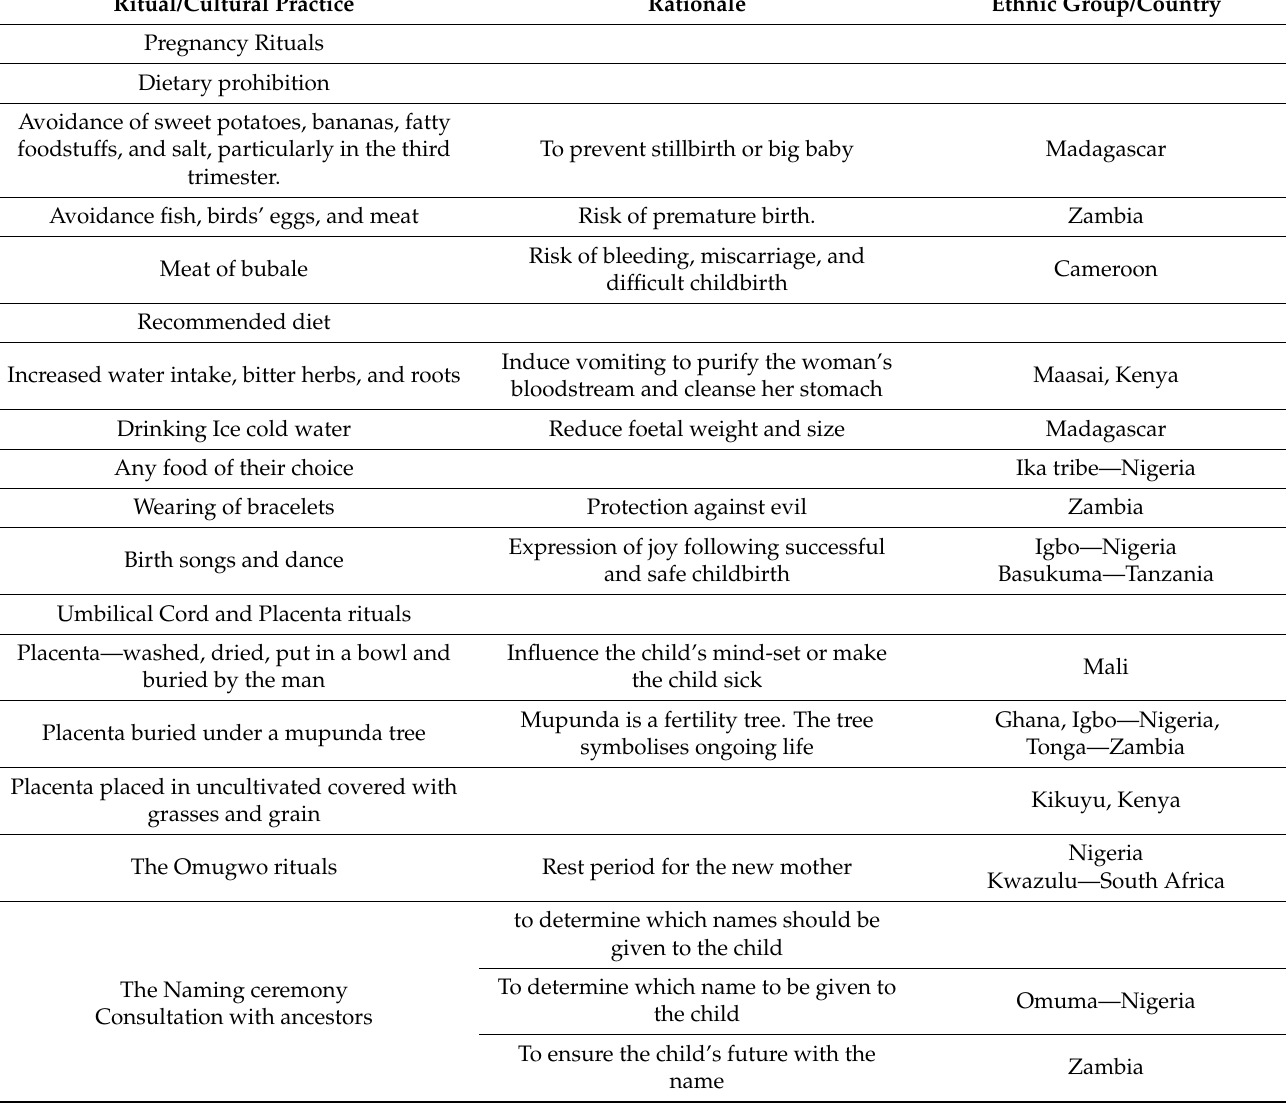
Table 3. Some examples of pregnancy and birth rituals according to